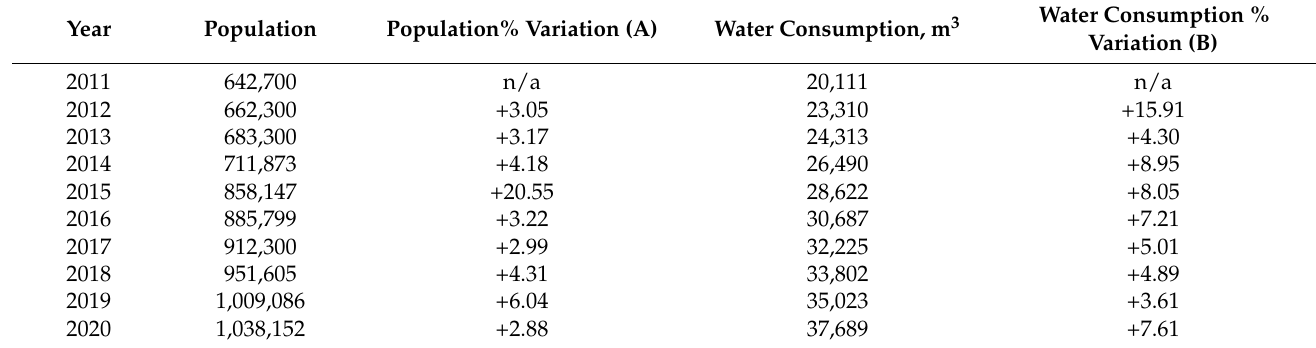
Table 1. Dynamics of population and water consumption change through 2011–2020 in Shymkent.